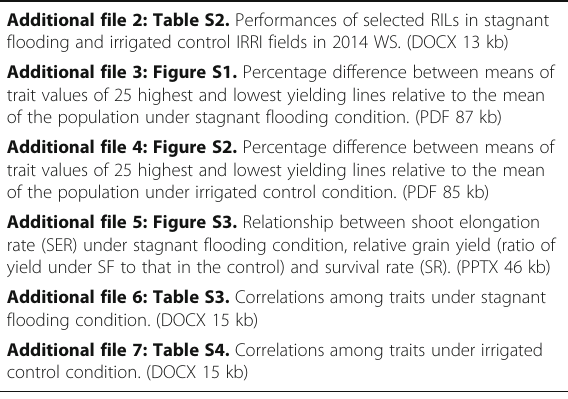
Additional file 1: Table S1. List of traits measured in both stagnant flooding and irrigated control conditions. (DOCX 13 kb)